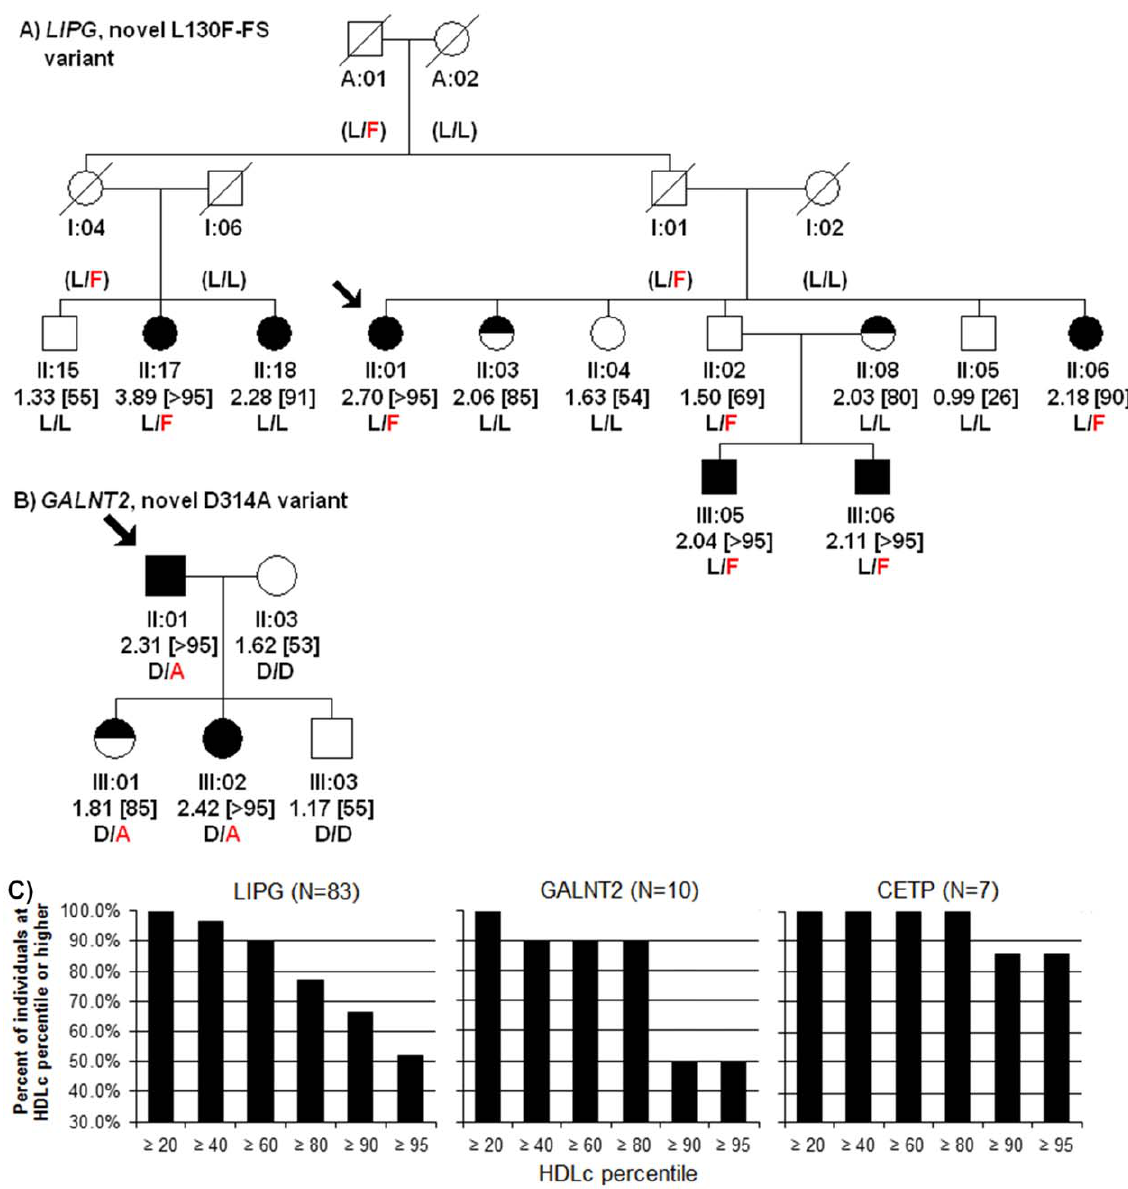
Figure 2. Representative segregation of mutations in families. A, B ) Segregation of ( A ) LIPG L130F-FS and ( B ) GALNT2 D314A with elevated HDLc. For each individual, the individual ID, HDLc (in mmol/L) plus [HDLc percentile], and genotype are shown. Squares, Males; Circles, Females; Arrow, proband. Filled shape, HDLc $ 90 th percentile; half-filled, HDLc between 80–89 th percentiles; empty shape, HDLc , 80 th percentile. Slash=deceased. C ) Percent of individuals in families with mutations at given HDLc percentiles or